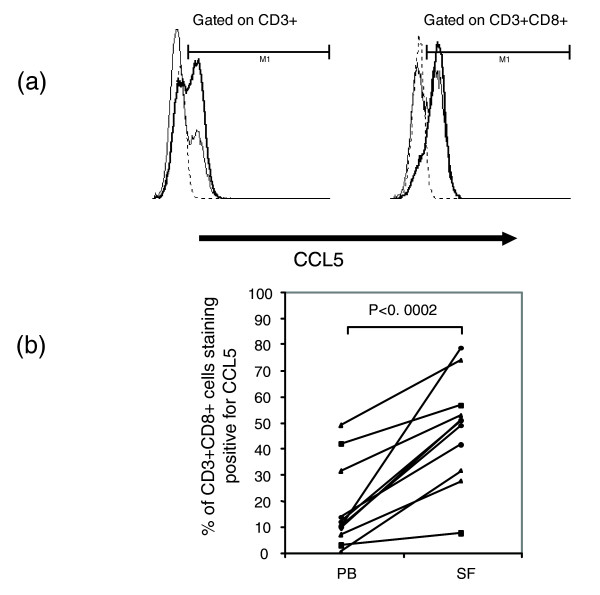
Intracellular flow cytometric analysis of CCL5+ synovial T cells. Peripheral blood (PB) and synovial cells were stained for CD3, CD8 and CCL5. (a) Histograms represent CCL5 expression in cells from PB (thin line), or synovial fluid (SF; bold line), compared to staining by isotype control (dashed line), with events gated either on all CD3+ cells (left panel), or CD3+CD8+ cells only (right panel). Marker (M1) indicates CCL5 positive cells. (b) Summary of flow cytometric analysis of CCL5 expression from 11 JIA patients (4 persistent oligoarticular, closed triangles; 5 extended oligoarticular, closed circles; and 2 polyarticular, closed squares), indicating number of CD3+CD8+ cells staining positive for CCL5 in PB and SF.